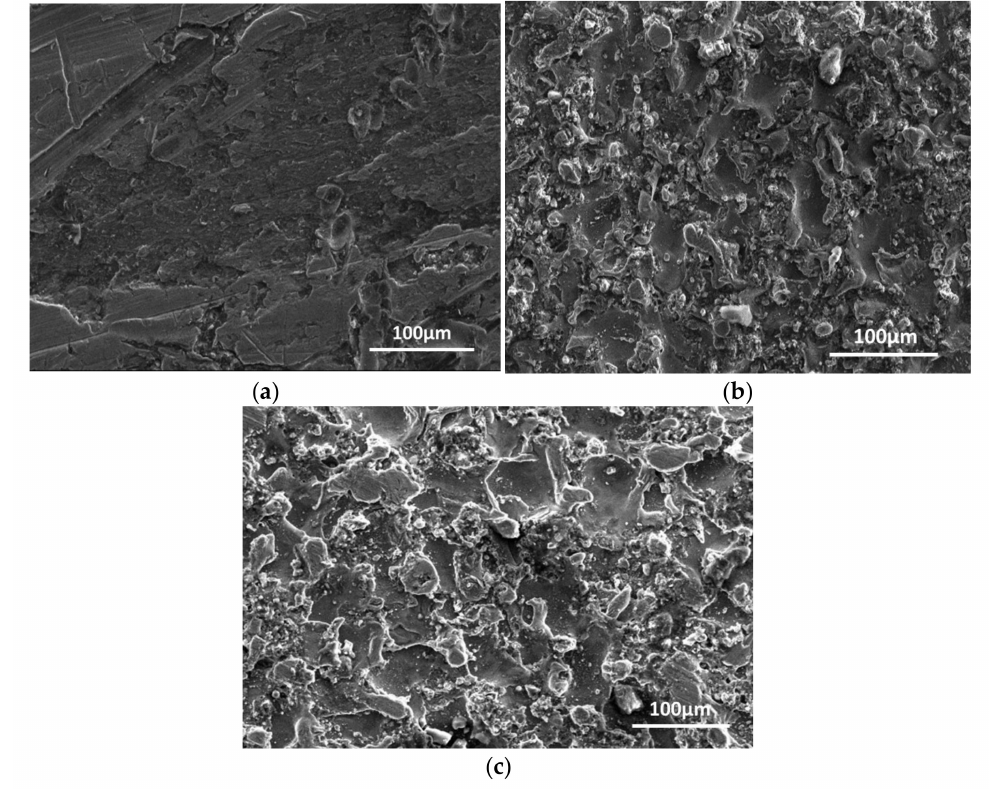
Figure 13. SEM images of AMC, ( a ) before machining at 250 × ; ( b ) machined surface as per best setting for maximum MRR at 250 × ; and ( c ) machined surface as per best setting for minimum overcut at 250 ×